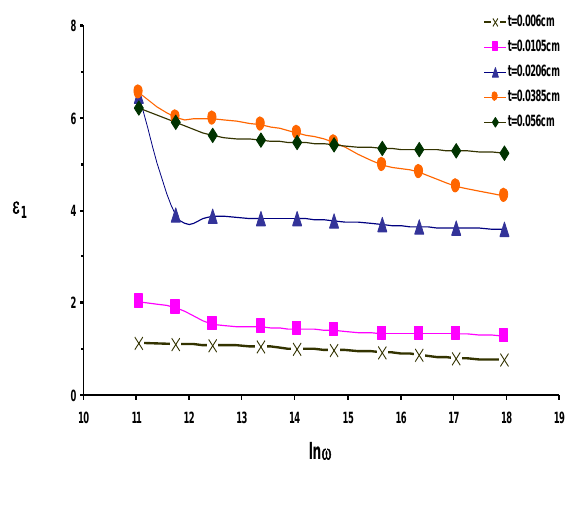
Fig.1: Variation of real part of permittivity (ε ) with frequency of PMMA films for 1 different thickness at room temperature .